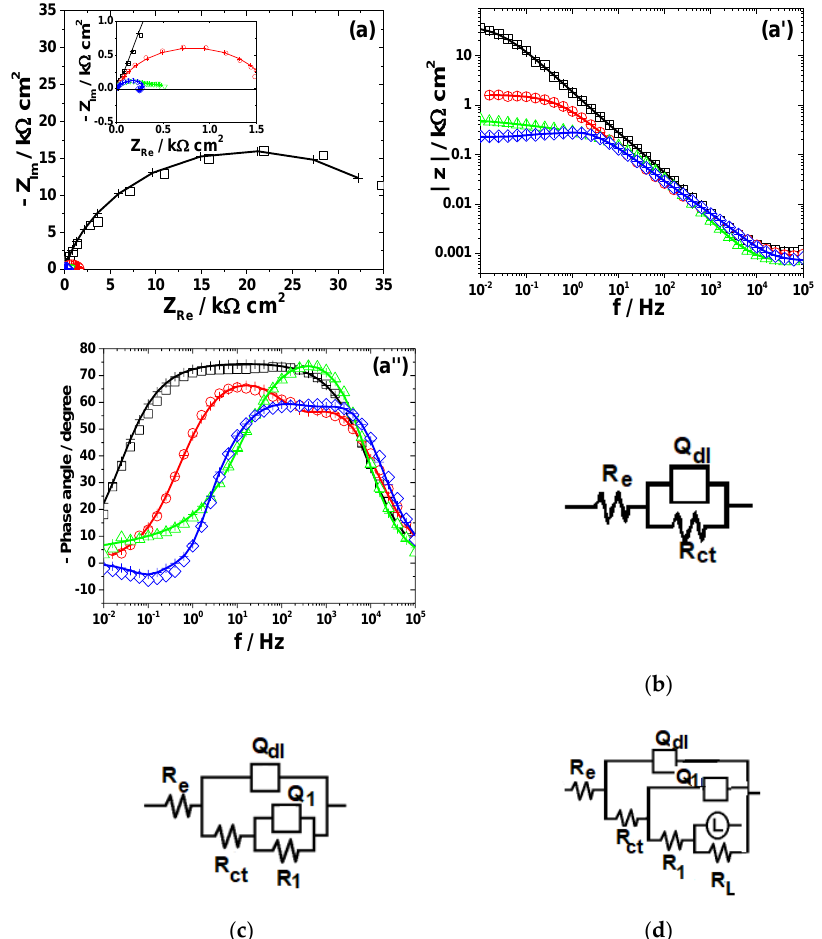
Figure 7. Displays the impedance diagrams of Fe immersed in the studied electrolytes. EIS results of Fe after immersion in different bromide-based electrolytes: Nyquist diagrams ( a ); Bode plot of |Z| vs. frequency ( a’ ); and Bode plot of phase angle vs. frequency ( a” ). The equivalent electrical circuits used for EIS fitting ( b – d ). Symbols represent the experimental data and lines with cross (—+—) correspond to the simulated spectra. Electrolytes: (□) Sol. A; ( O ) Sol. B; (◊) Sol. C; and (Δ) Sol. D.